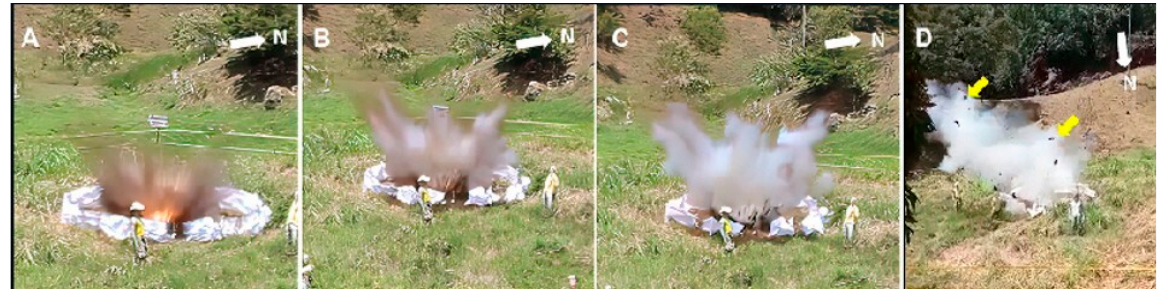
Figure 4. Video snapshots during the explosion of the homemade AP landmine. ( A – C ) Recording from the east sector of the experimental field. ( A ) In the center of the explosion it is possible to observe a “fireball” (exothermic reaction) while a column of greyish smoke, is projected up and sideways over the fence. The latter begins to disintegrate; ( B ) A few hundredths of seconds after the explosion, the light disappears while the grayish smoke column continues to expand. Major effects on fence are evident; ( C ) The smoke is whiter in color than at the beginning of the explosion; ( D ) Recording from the north sector of the experimental field. The smoke moved eastward along with the wind direction. Some soil particles were projected towards this sector (a few of them are marked with a yellow arrow). Figure 5F shows the projection of solid elements into the western sector of the field. The elements projected towards the southern and eastern sector of the field are not shown; (N) North view.